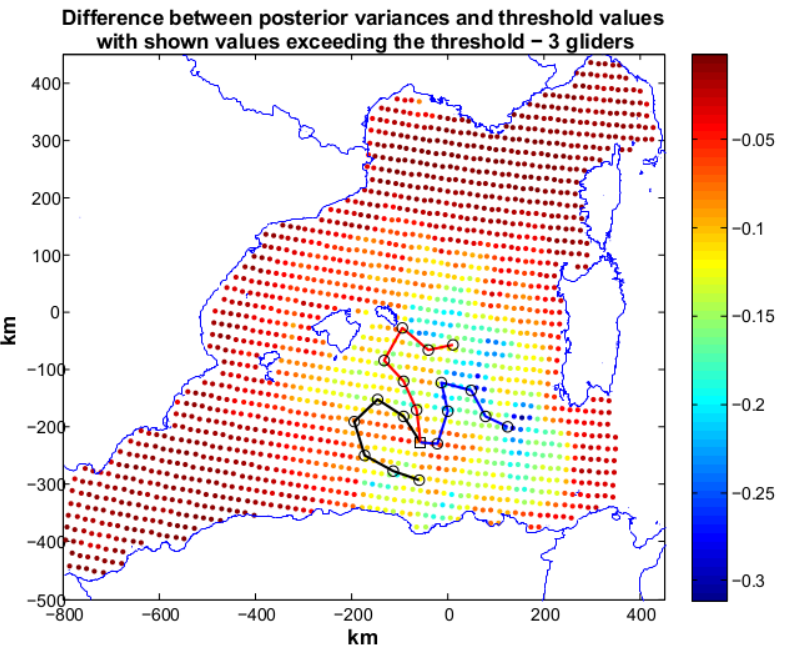
Figure 6. Scenario 1: planned paths for three gliders. The solution is characterized by J η = 0 and J c = 2. In the figure we show also the difference between posterior variances and relative values of the objective threshold. All the posterior variances in the operation area respect the requirements of the